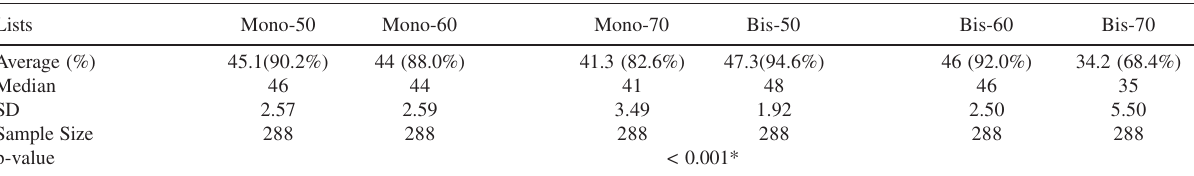
Table 2 - Comparison by ANOVA between the averages of correct responses for the word lists (monosyllable and bisyllable) at the 3 compression levels